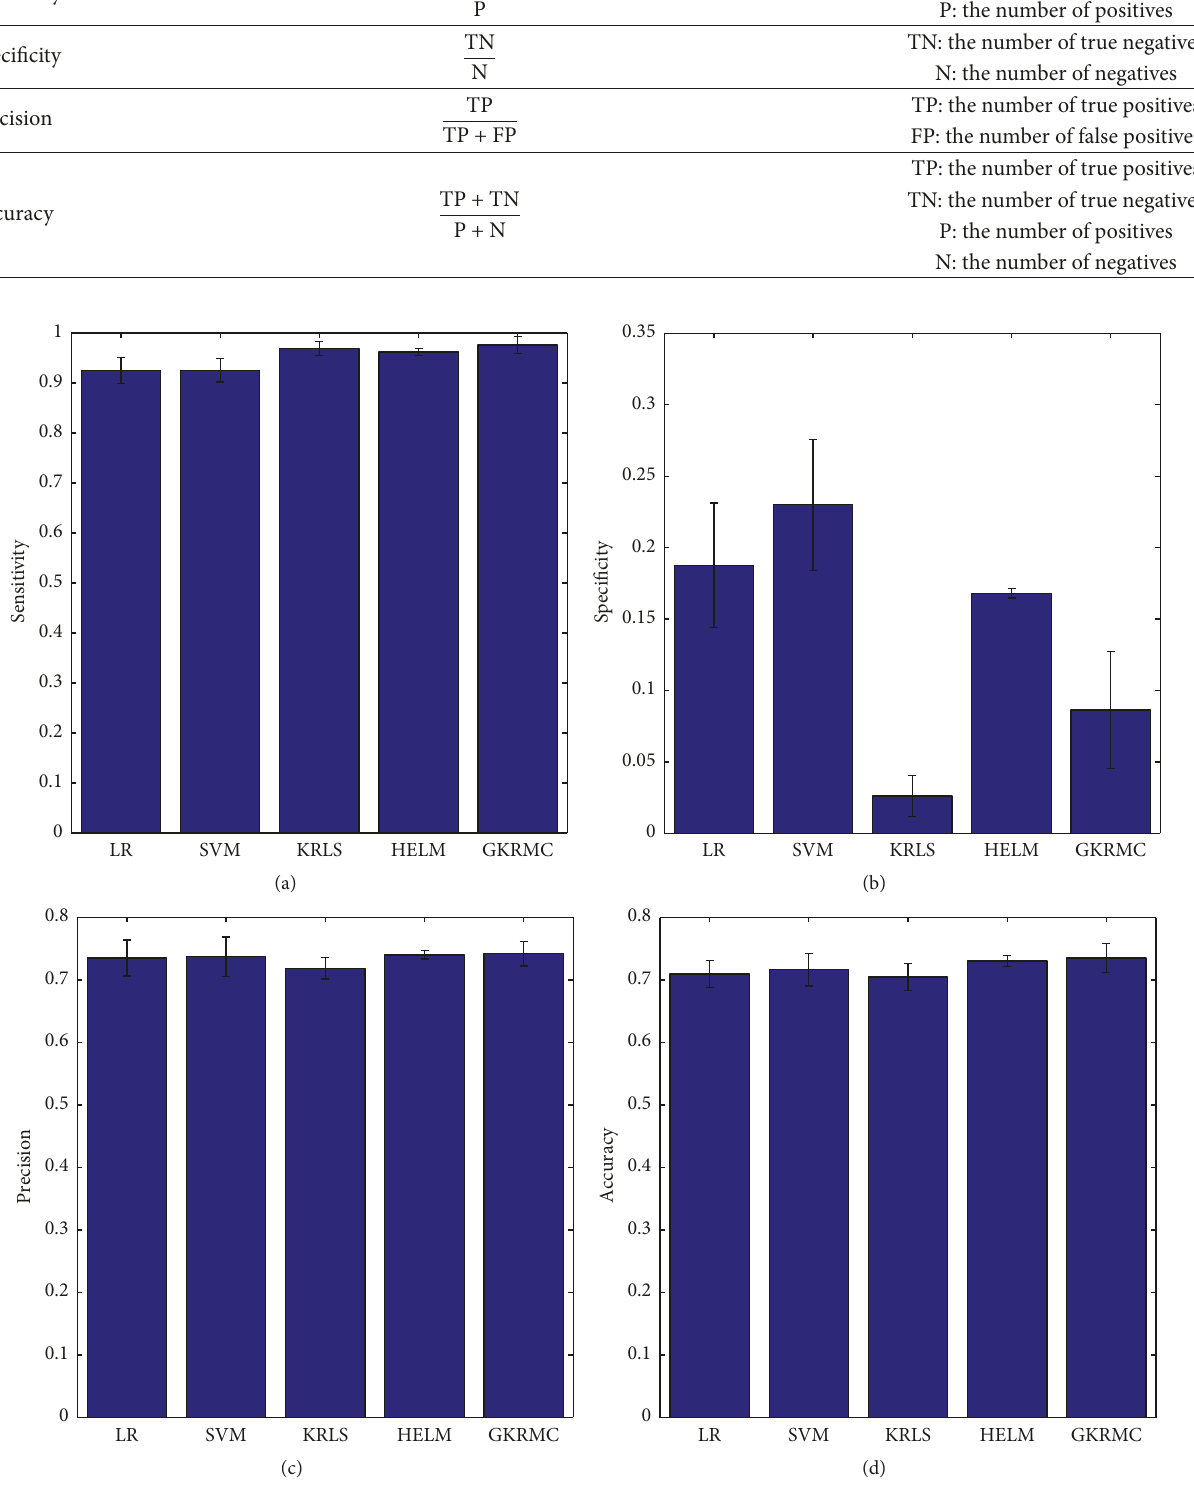
Figure 5: Predictive performance for the LR, SVM, KRLS, HELM, and